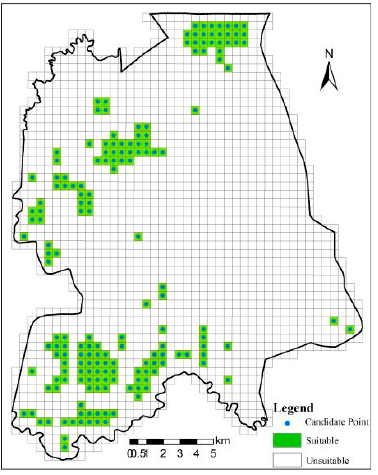
Figure 6. Suitability map.